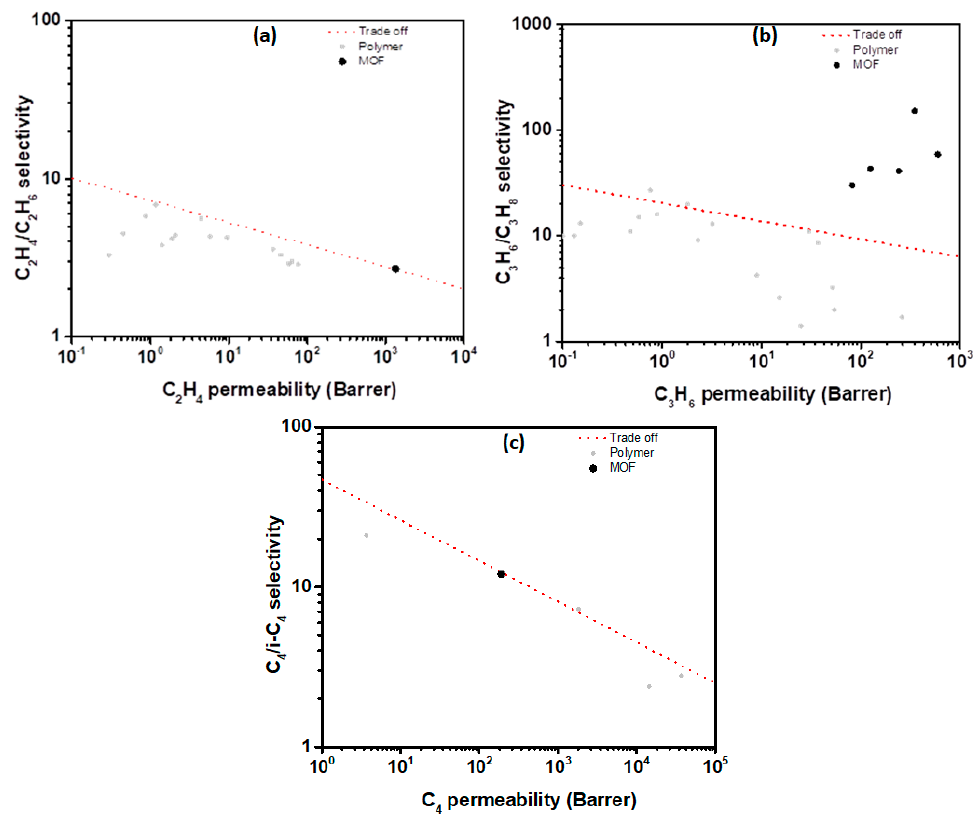
Figure 73. Comparison of permeation properties of MOFs to the performance of polymeric materials reported in the literature for membrane-based: ( a ) C 2 H 4 /C 2 H 6 separation ( b ) C 3 H 6 /C 3 H 8 separation, ( c ) C 4 H 10 /i-C 4 H 10 separation. All the data points are listed in the supporting information (Tables S5–S7).